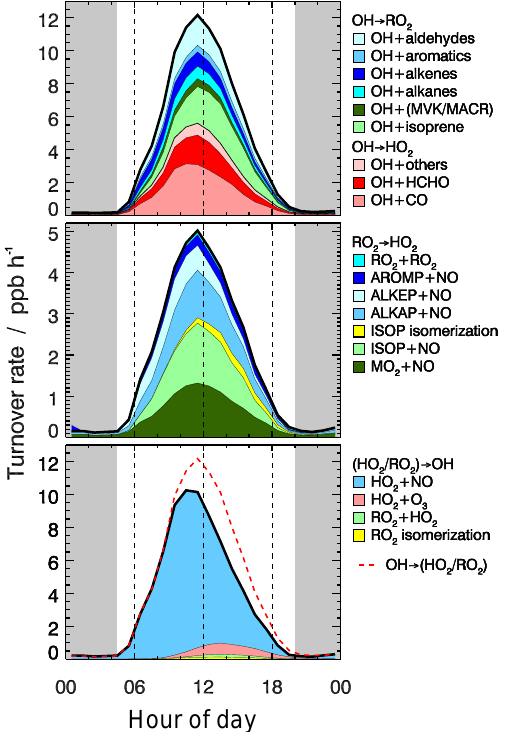
Figure 11. Hourly median diurnal profiles of turnover rates (model results) of radical propagation reactions between OH, HO 2 and RO 2 radicals. ALKAP: alkane-derived peroxy radicals; ALKEP: alkene- derived peroxy radicals; AROMP: aromatic-derived peroxy radi- cals. Grey areas indicate